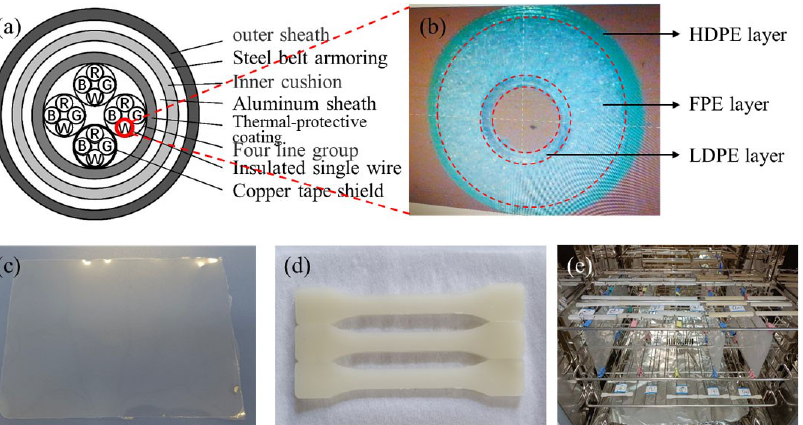
Figure 1. Structure and sample diagram ( a ) the structural of frequency-shift pulse voltage track cable, ( b ) the microscope diagram of “skin-bubble-skin” insulation layer, ( c ) PE film sample, ( d ) dumbbell- shaped samples, and ( e ) sample placement in the thermo-oxidative aging